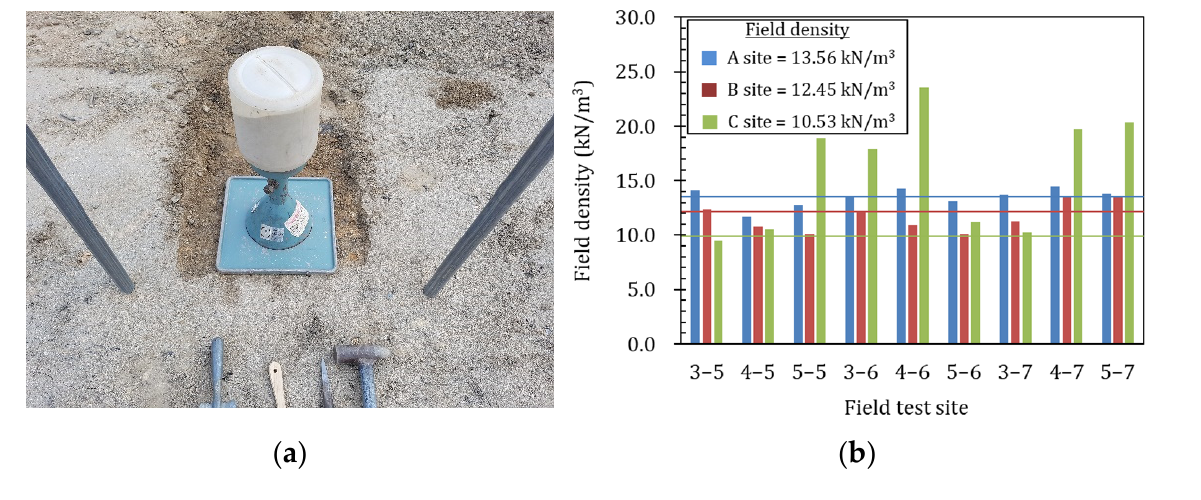
Figure 8. Field dry unit weight of soils. ( a ) field dry unit weight test; ( b ) results of field dry unit weight for site A, site B, and site C. Table 4. Field dry unit weight on site A, site B, and site C.